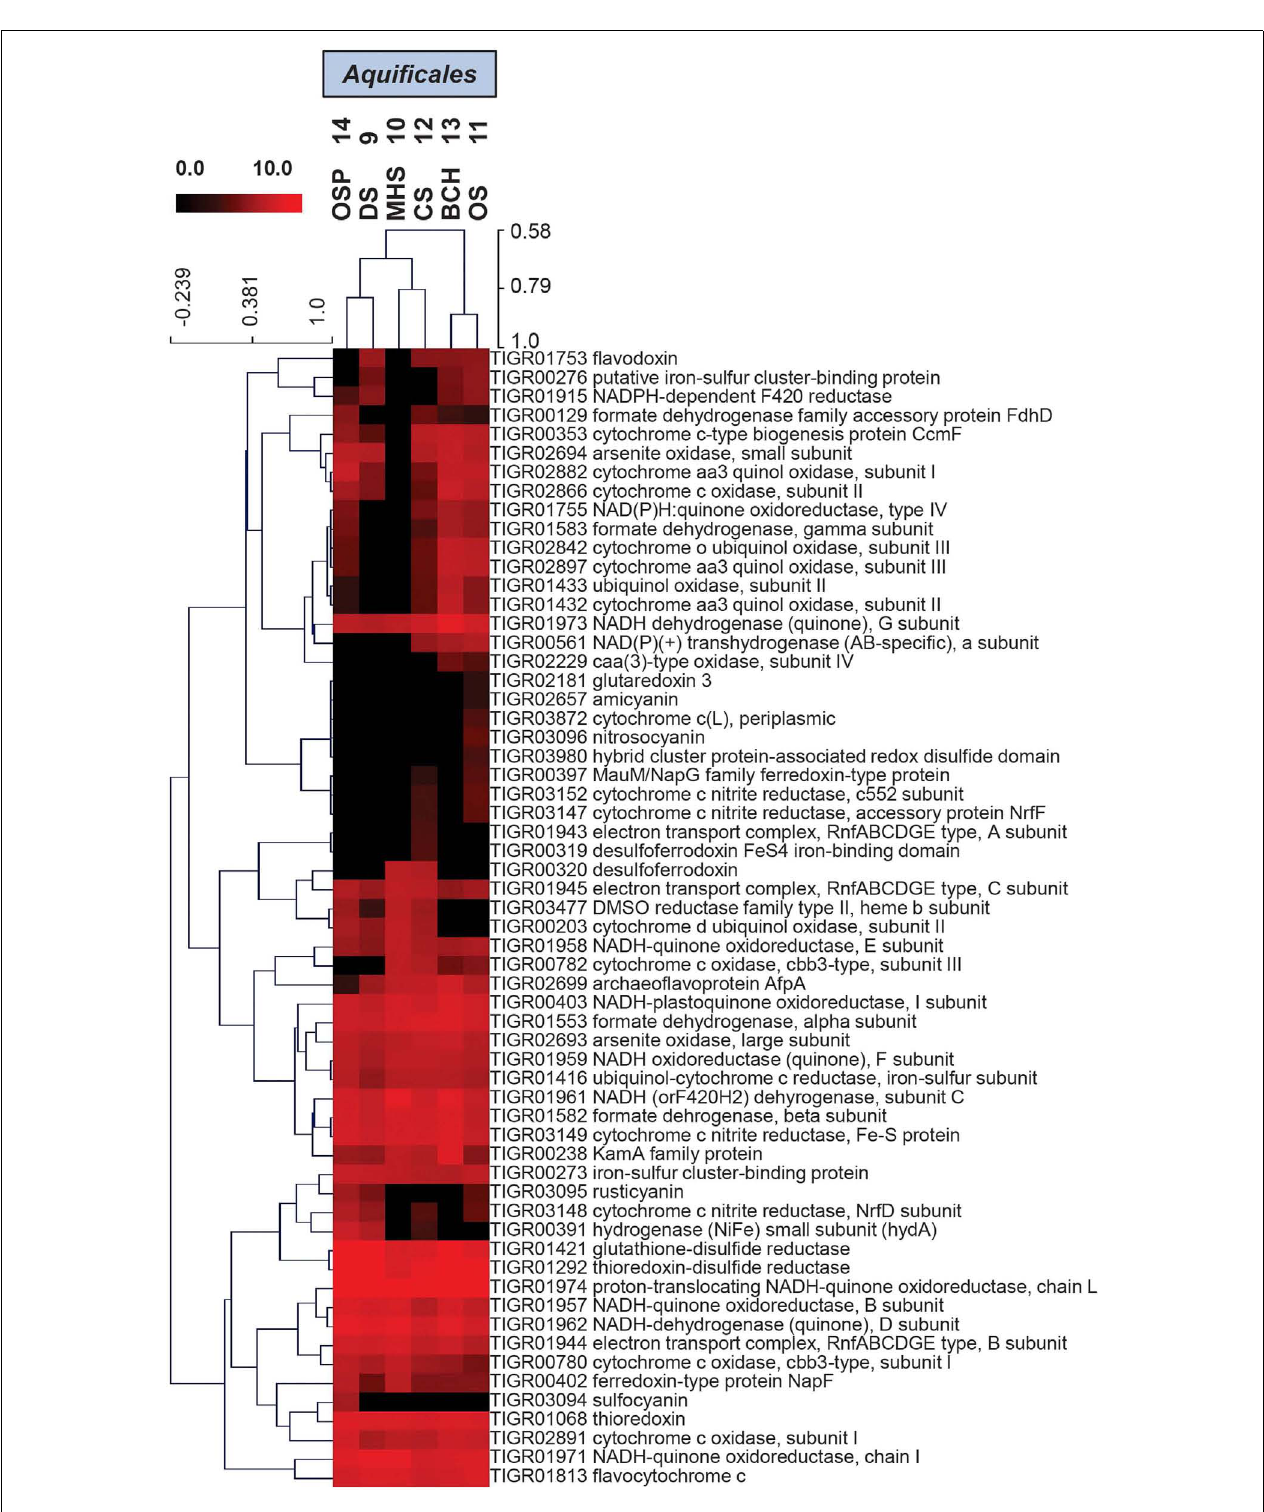
Subunits of the protein complexes were only represented by one representativeTIGRFAM family. Pearson correlation was used as the distance measure for average linkage agglomerative clustering. Sites cluster consistent with pH and the presence or absence of sulfide.